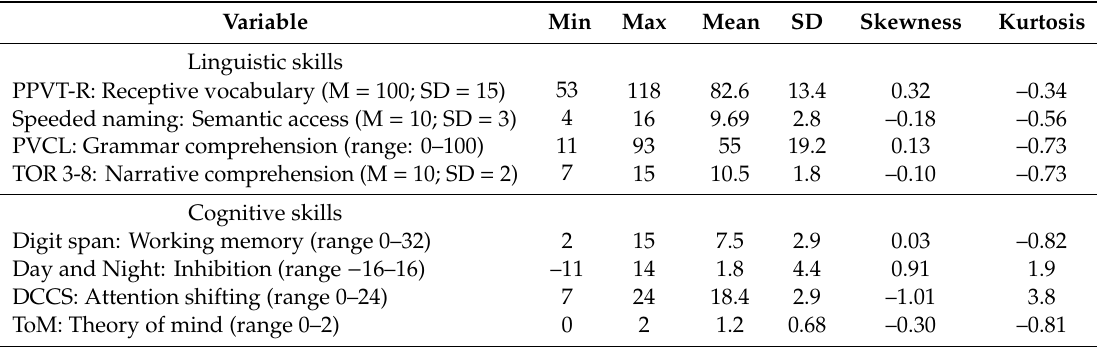
Table 2. Descriptive statistics (range, mean, standard deviation, skewness and kurtosis) for age and performance in linguistic and cognitive tasks.